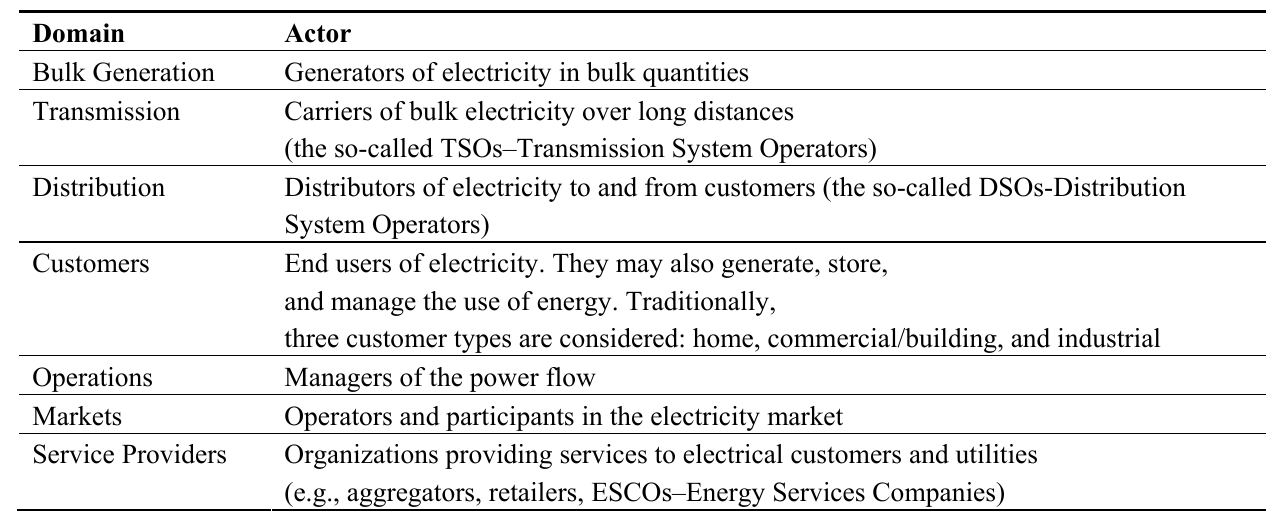
Table 1. Domains and actors in the NIST Smart Grid conceptual model